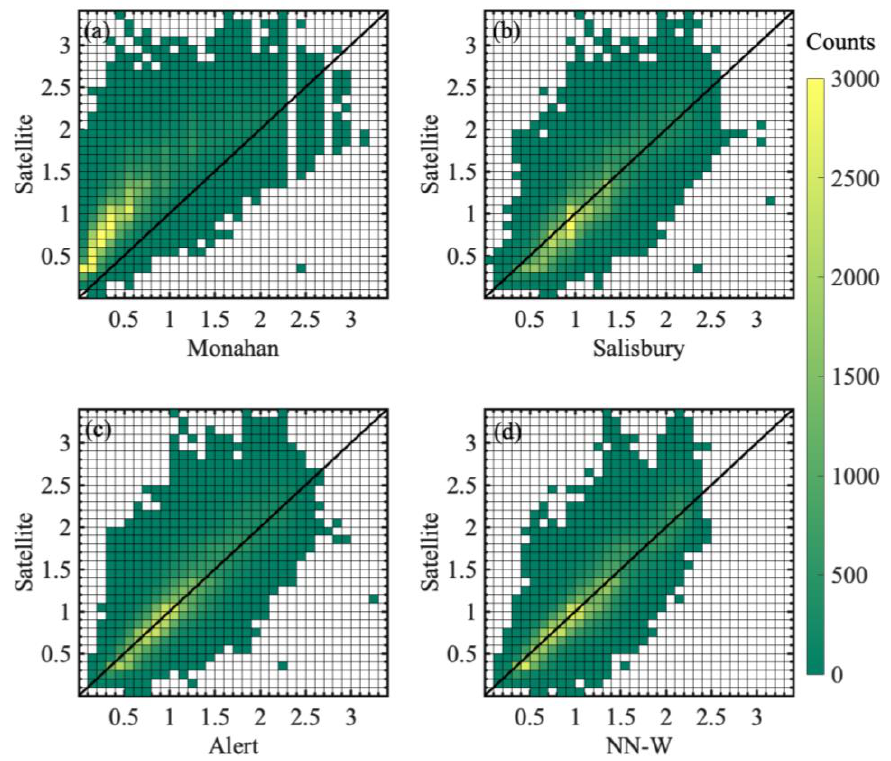
Figure 5. Binscatter plots of satellite-derived W data with W values calculated by different parame- terizations; ( a ) M80; ( b ) S13; ( c ) A16; ( d ) NN-W.